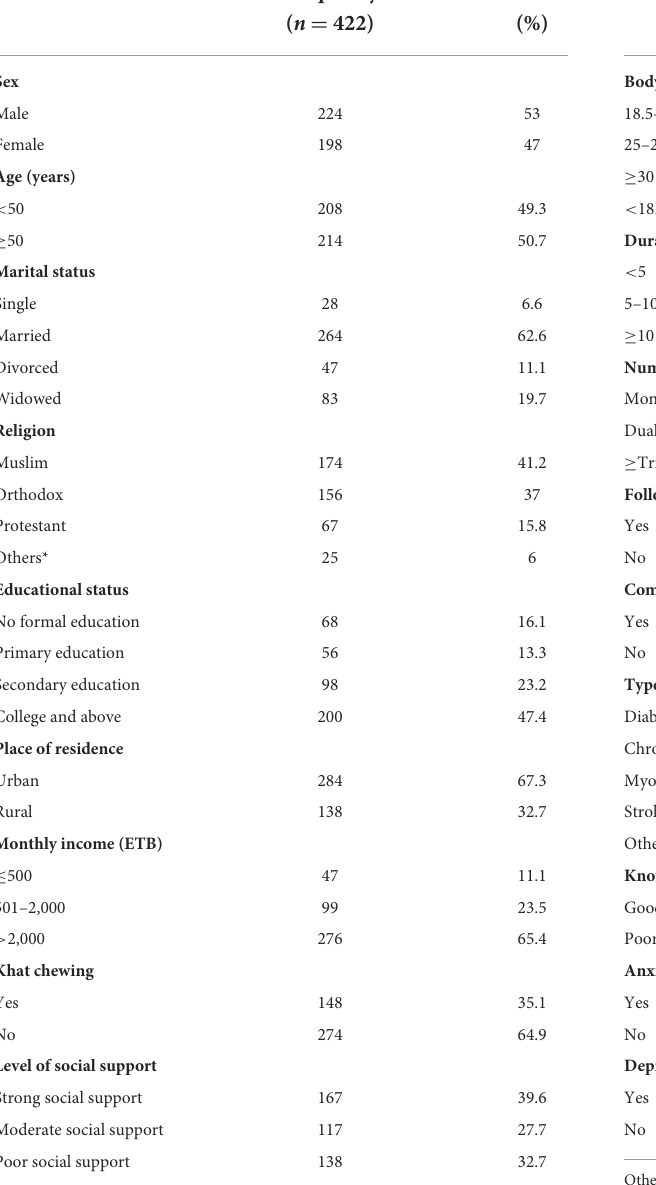
TABLE 1 Sociodemographic characteristics of hypertensive patients on follow-up at public Hospitals in the Harari regional state and Dire Dawa City administration, Eastern Ethiopia, 2022 ( n = 422).